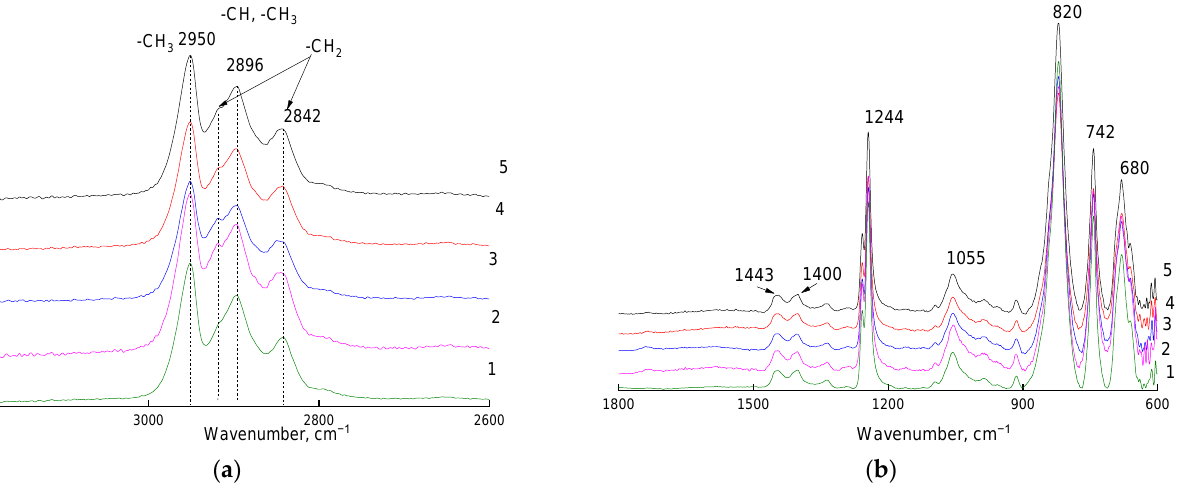
Figure 1. Fragments (( a ): 2600–3200 cm − 1 region; ( b ): 600–1800 cm − 1 region) of ATR-IR spectra (ZnSe crystal) of the PVTMS film recorded on the side opposite to the flow of the fluorinating agent. Curve 1: original film; curves 2–5: films fluorinated for 15, 30, 45, and 60 min, respectively.